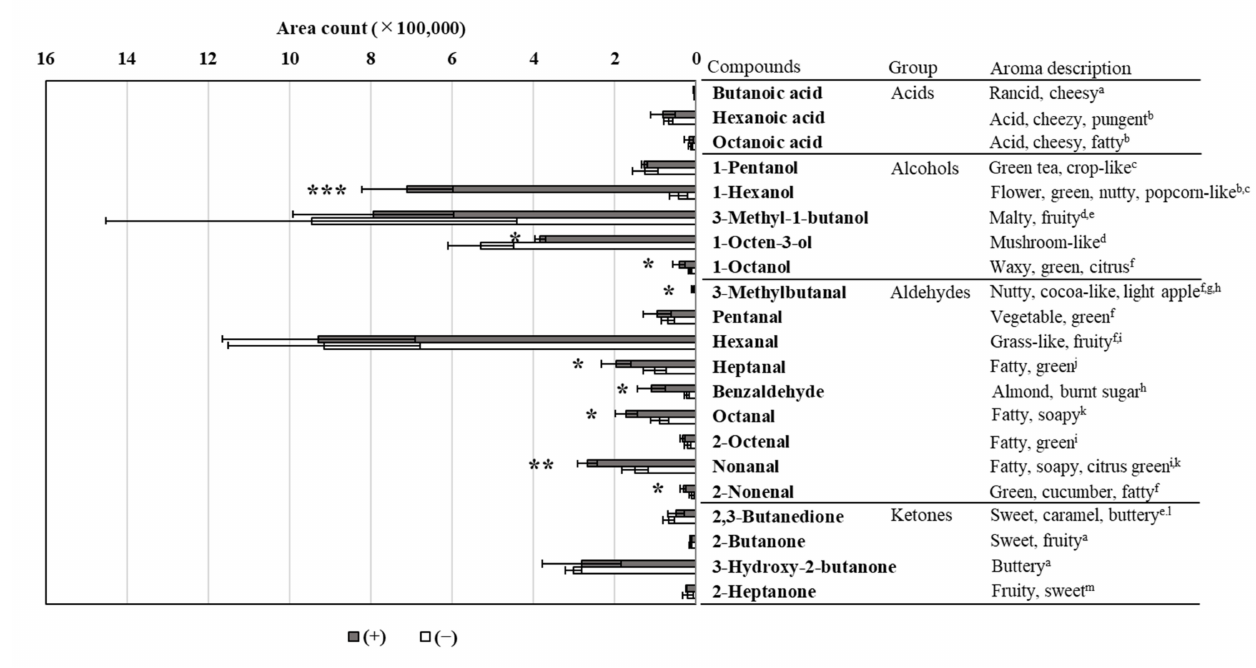
Figure 2. Area count of volatile aromatic compounds produced by raw meat of dry-aged beef, with (+) or without ( − ) direct fungal-rub inoculation, after 26 days. Values are expressed as mean ± standard deviation (n = 3). *** p < 0.001; ** p < 0.01; * p < 0.05. The following literature was used as